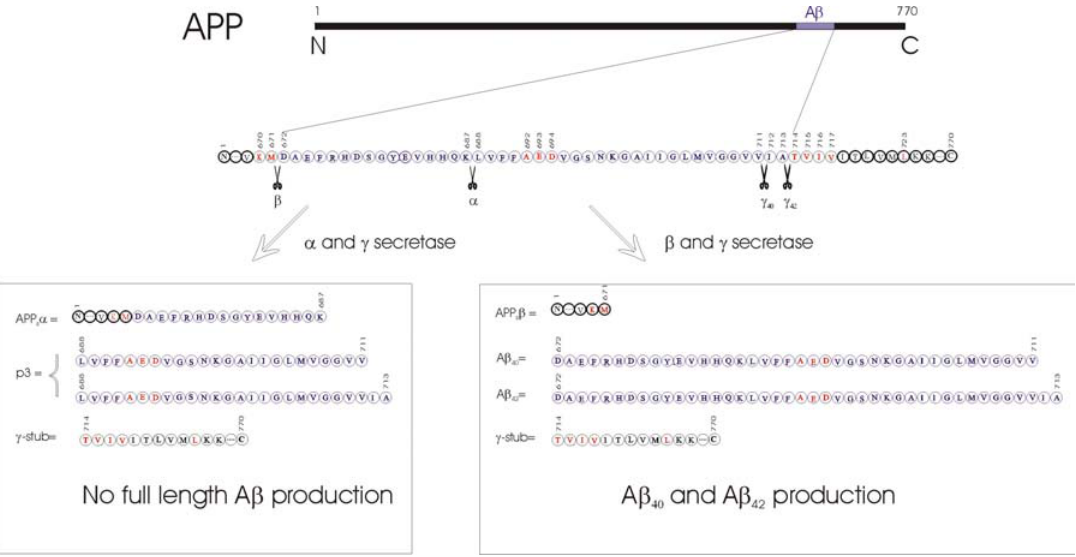
FIGURE 2. Proteolytic cleavage of APP770. The sequence within APP that contains A β as well as part of A β flanking sequence is expanded and shown by the single-letter amino acid code. Amino acids comprising the A β sequence are shown in blue, flanking amino acids in black. Amino acids with currently known missense mutations are indicated in red. The different proteolytic fragments resulting from protease activities of α , β, and γ− secretase are shown (APPs = soluble APP).